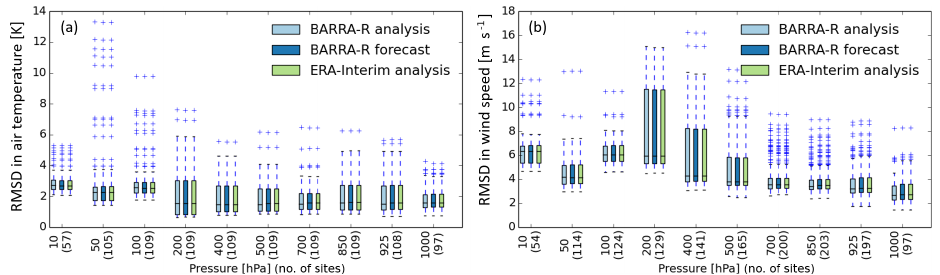
Figure 7. Box plots showing the RMSD distribution of BARRA-R t 0 + 6 forecast and t 0 analysis, as well as ERA-Interim analysis for (a) temperature and (b) wind speed at multiple sites in the BARRA-R domain. RMSD is calculated for temperature and wind speed at pressure levels of 10, 50, 100, 200, 400, 500, 700, 850, 925, and 1000hPa against pilot balloon and radiosonde observations at 00:00 and 12:00UTC. The numbers of sites are indicated in brackets.